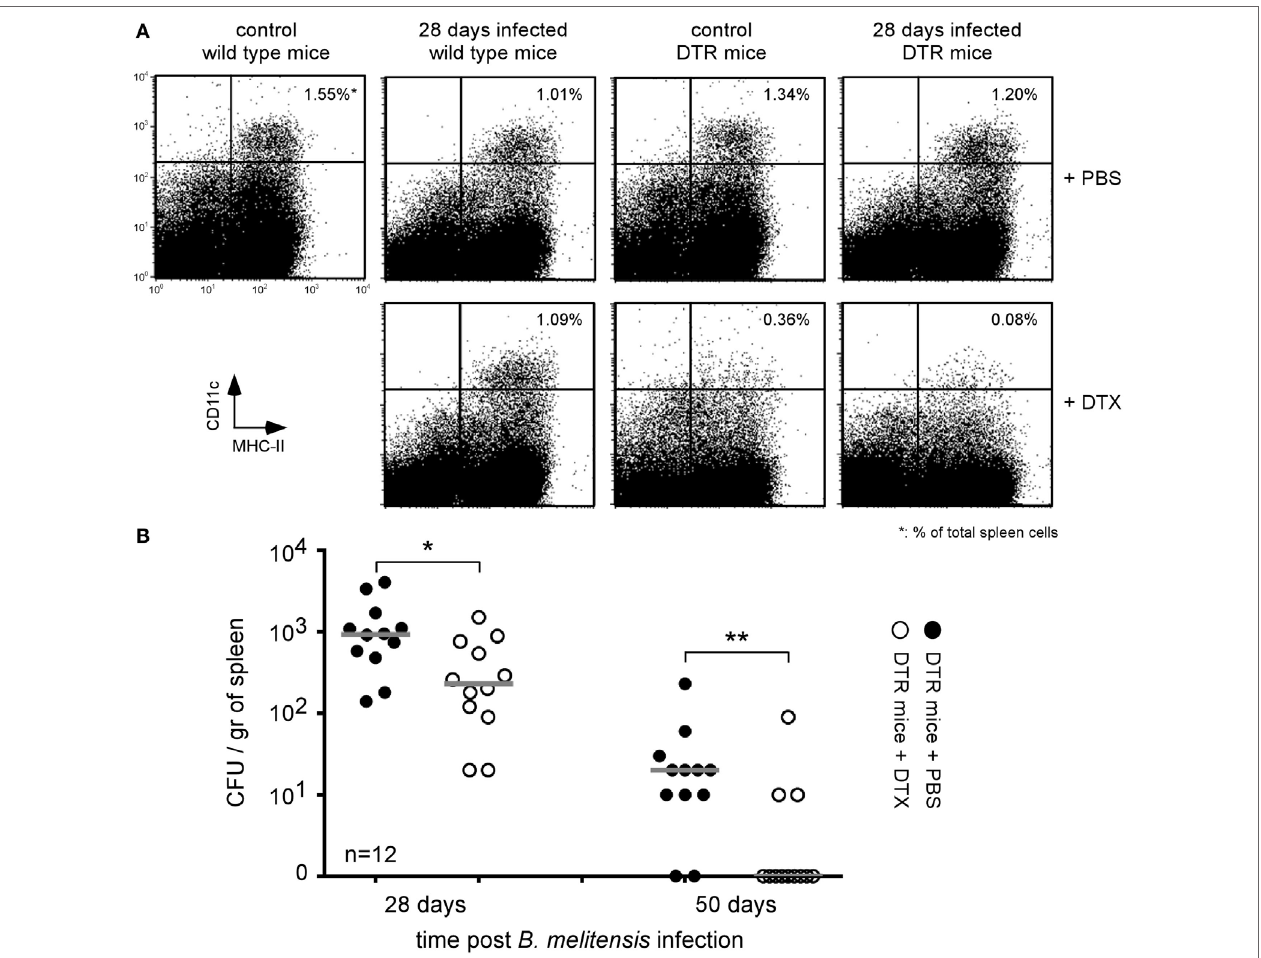
FigUre 1 | Brucella persisted in CD11c + reservoir cells in the spleen of chronically infected wild-type C57BL/6 mice. Wild-type and DTR-CD11c C57BL/6 mice received i.n. 2 × 10 4 CFU of mCherry- Brucella melitensis in PBS or PBS alone (control group) . 26 or 48 days later, the mice received 500 ng of diphtheria toxin by i.p. route in 500 µl of PBS or PBS alone. Two days later (28 or 50 days post Brucella infection), the mice were sacrificed, and the spleens were harvested. (a) Flow cytometry analysis of CD11c and MHCII expression on spleen cells. The data show a representative dot plot for individual mice. (B) The data represent the number of colony-forming units per gram of spleen for each group of mice at the indicated time of infection. Gray bars represent the median. n denotes the number of mice used for each group (* p < 0.05, ** p < 0.01). These results are representative of at least two independent